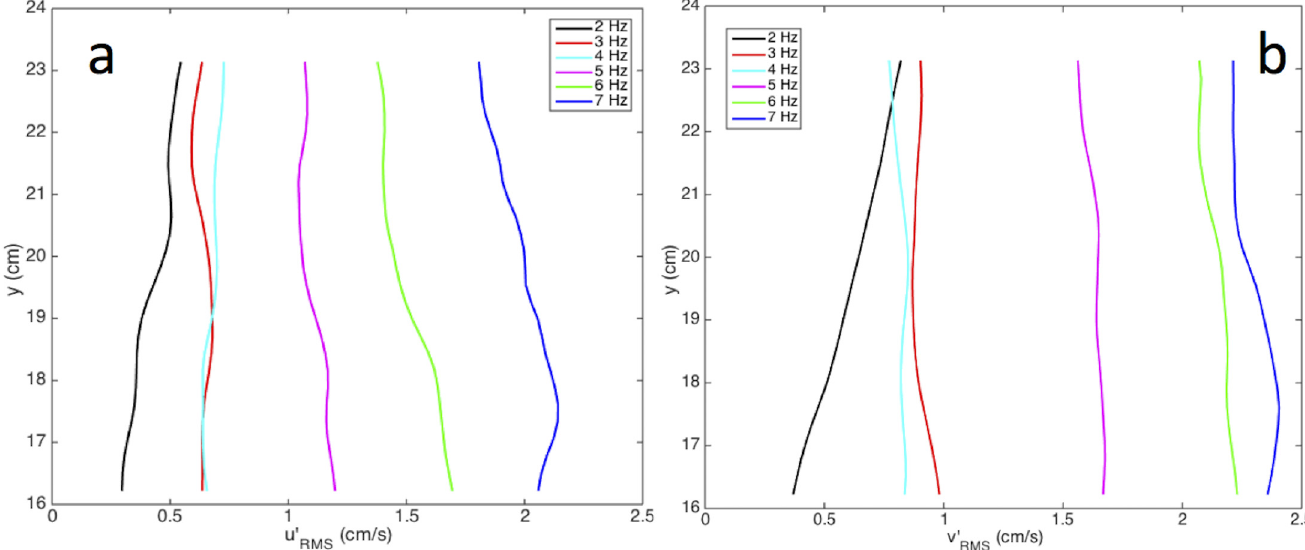
Fig 5. Horizontally averaged vertical profiles of the RMS of the (a) horizontal and (b) vertical turbulent fluctuations for all grid frequencies (see